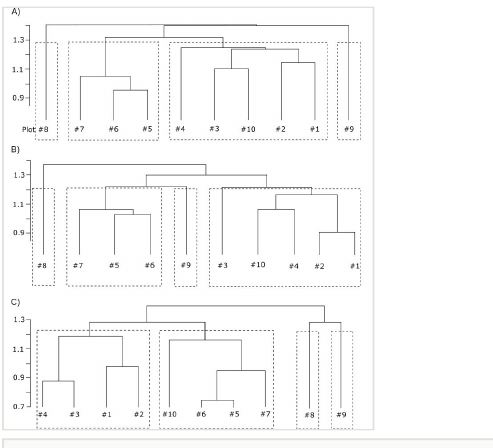
Figure 5. Cluster dendrograms built by average agglomerative clustering (UPGMA) based on chord distance matrix of abundance data of fungi amongst 10 plots of macromycetes observations in di ff erent forest types in vicinities of Khanty-Mansiysk, West Siberia: A) all trophic groups altogether, B) separate analysis for saprotrophic species, C) separated analysis for ectomycorrhizal species.